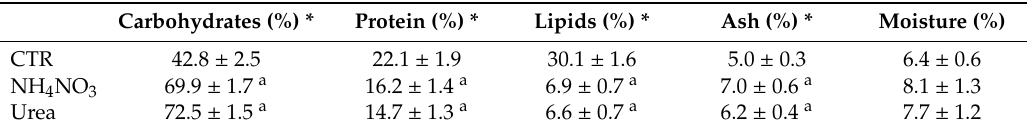
Table 1. Proximate composition of seeds from hemp plants fertilized by ammonium nitrate (NH 4 NO 3 ) and urea. Data are means ( n = 4) ± standard error (SE). CTR, control seeds. * Dry matter of